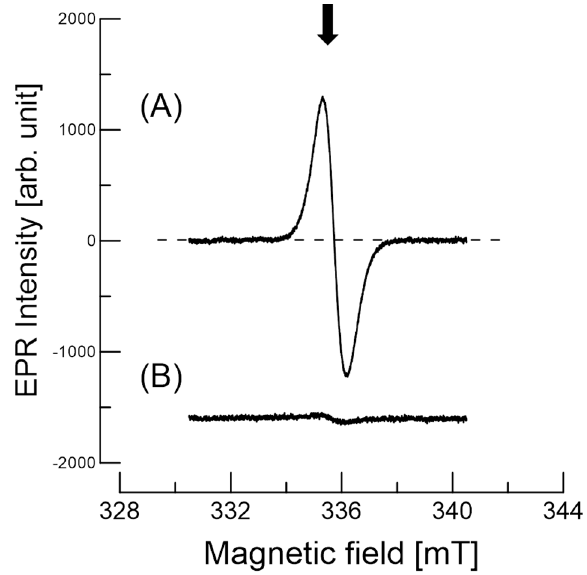
Figure 5. EPR spectra obtained for the g~2.002 region of ( A ) the C. japonica seed coats at ambient storage conditions and ( B ) the cotyledon of the seeds. Each spectrum was obtained with a single scan. The arrow indicates the stable radical center.